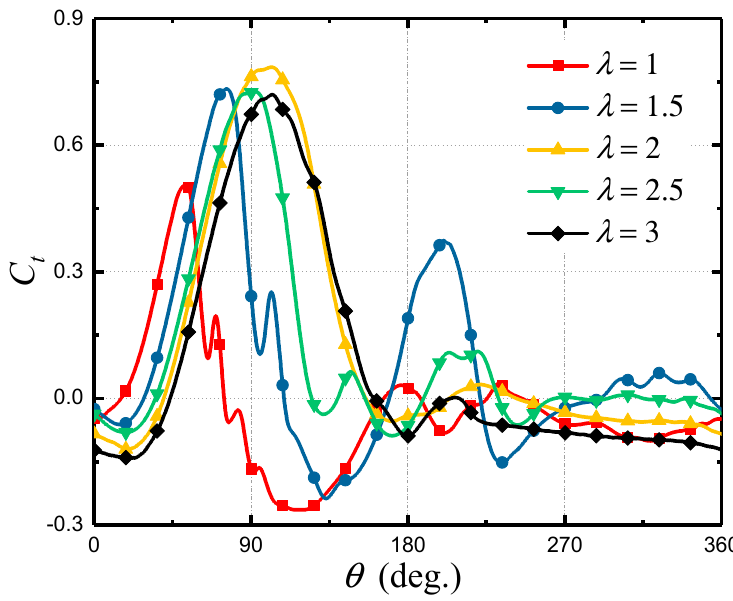
Figure 12. Tangential force coefficient of a blade with azimuth.